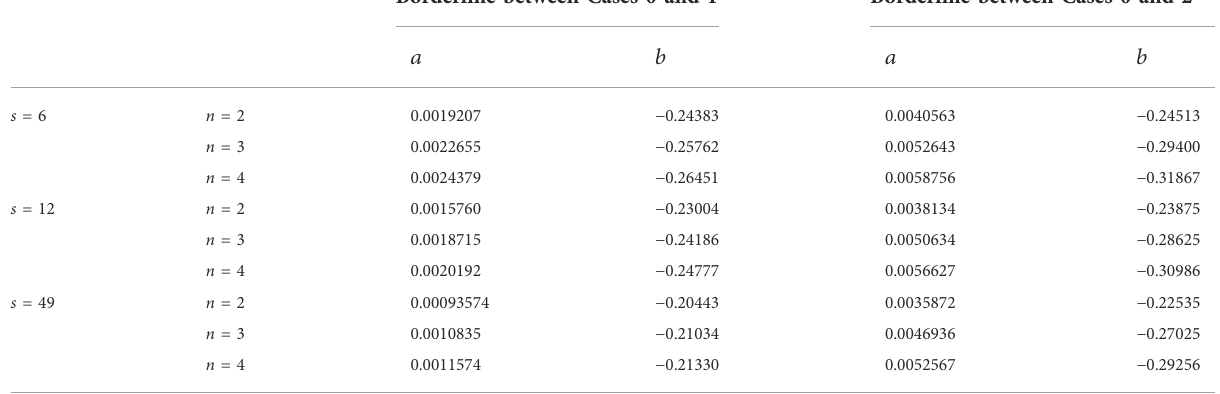
TABLE 4 Borderline conditions between single (Case 0) and platooning operation (Case 1 and 2).